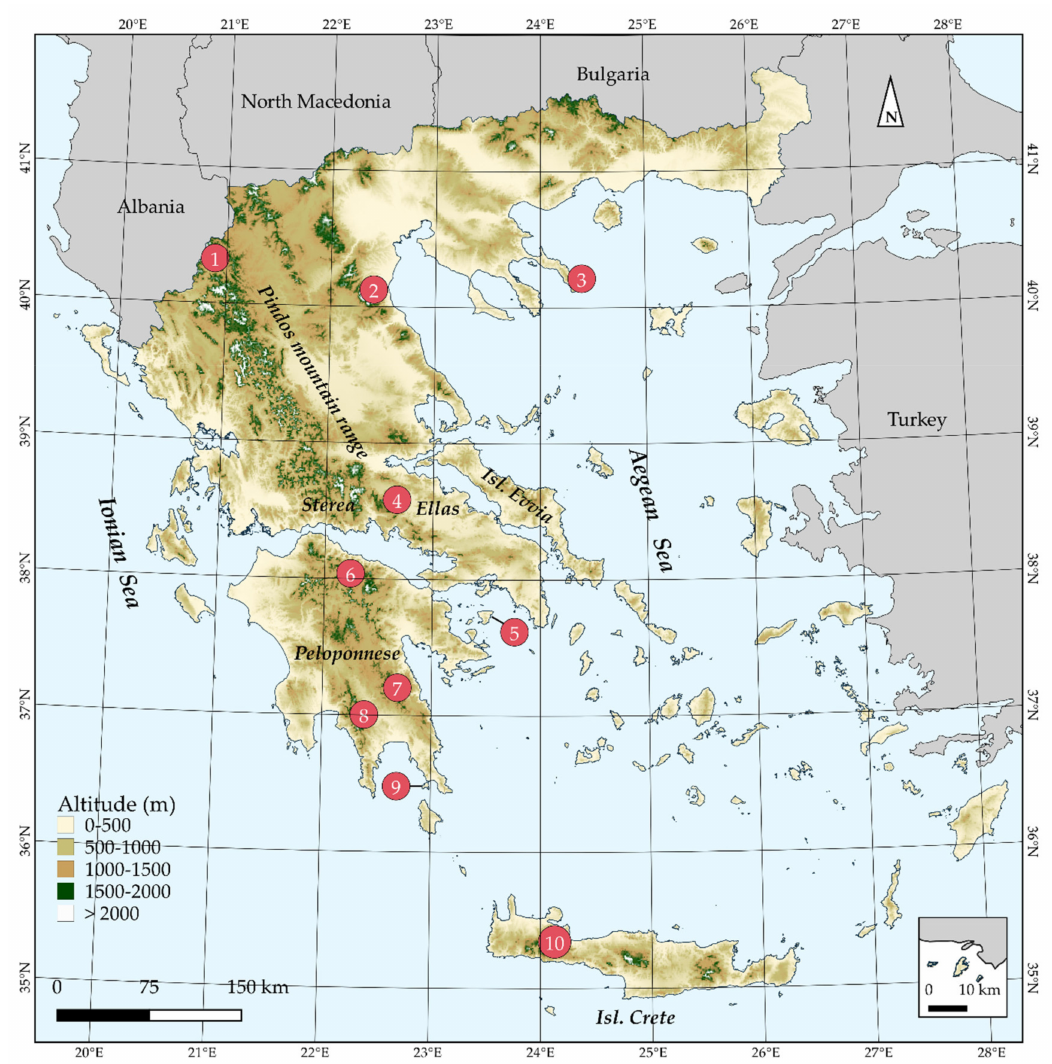
Figure 1. Map of Greece presenting major mountain massifs, as well as Aegean islands mentioned in the text. 1: Mt. Gramos, 2: Mt Olymbos, 3: Mt Athos, 4: Mt Parnassos, 5: Isl Aegina, 6: Mt Chelmos, 7: Mt Parnonas, 8: Mt Taygetos, 9: Isl Elafonisos, 10: Lefka Ori mountain range. The inset map depicts the island of Megisti (Kastelorizo) and its nearby